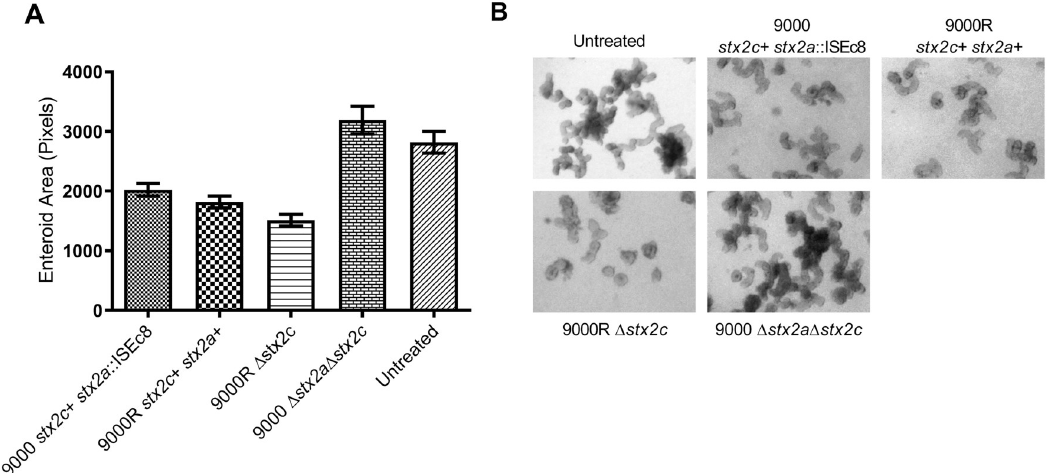
Fig 3. Stx2 inhibition of ileal organoid budding. Mean organoid size (A) and representative images of Stx2 treated or untreated organoids (B) are shown. Organoids were treated with supernatants derived from strains 9000 (n = 3784), 9000R (n = 4005), 9000R Δ stx2c (n = 964), 9000 Δ stx2a Δ stx2c (n = 1540) or untreated (n = 1409). Organoid size was determined from organoids treated with a range of toxin supernatant dilutions (1/200–1/500) used in each experimental replicate. Mean organoid size ± SEM is shown for four experimental replicates (n =